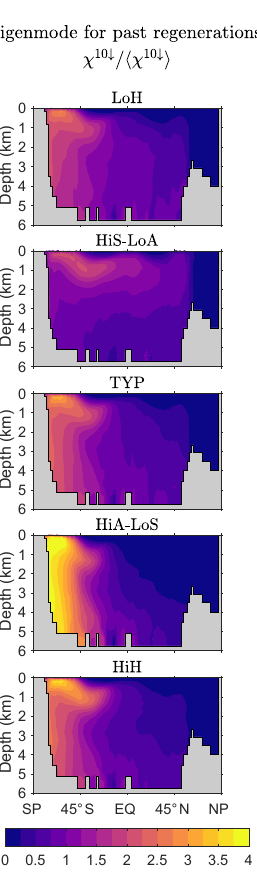
Figure 5. Normalized global zonal averages of the concentration of DFe that has passed n = 10 times through the biological pump since birth regardless of source type, χ 10 ↓ , to show the eigenpat- terns of our five representative state estimates (Table 1). The zonal averages are normalized by the global